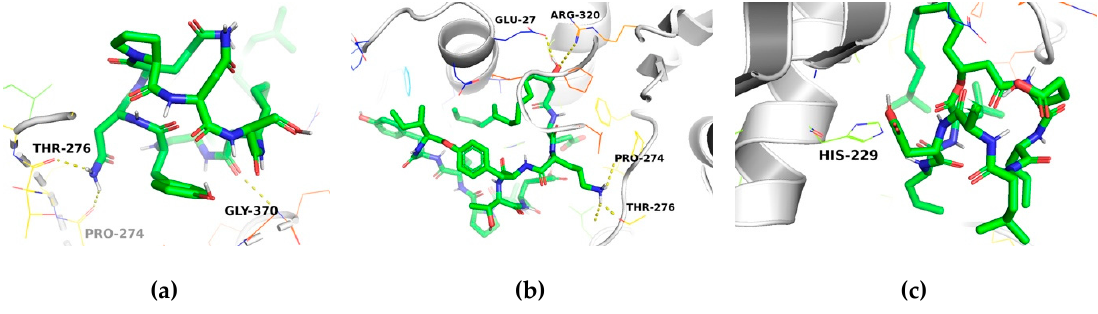
Figure 4. Molecular docking simulation showing the interaction of ( a ) iturin A, ( b ) fengycin, and ( c ) surfactin (green and blue) with active site residues of β -tubulin (grey).